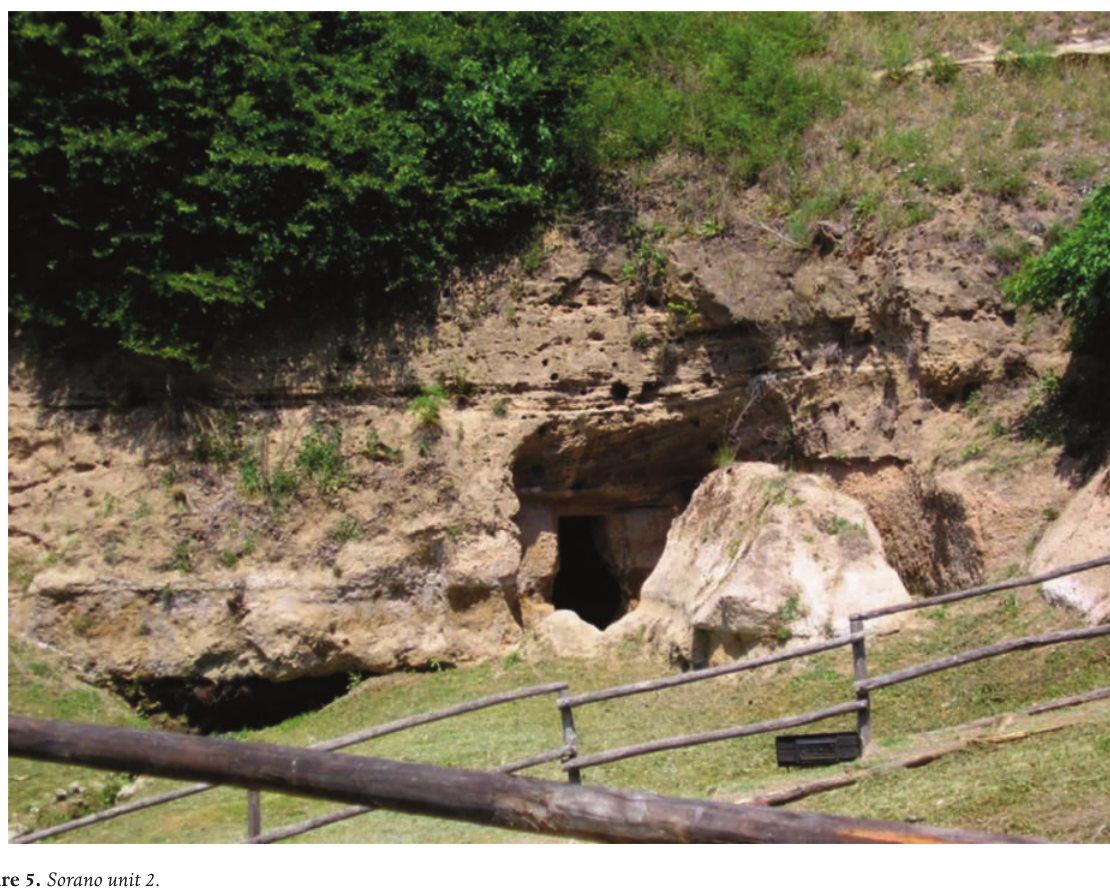
Figure 5. Sorano unit 2 .